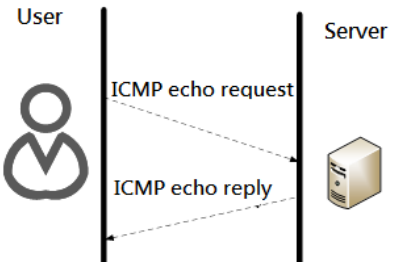
Figure 3. Normal ICMP diagram.